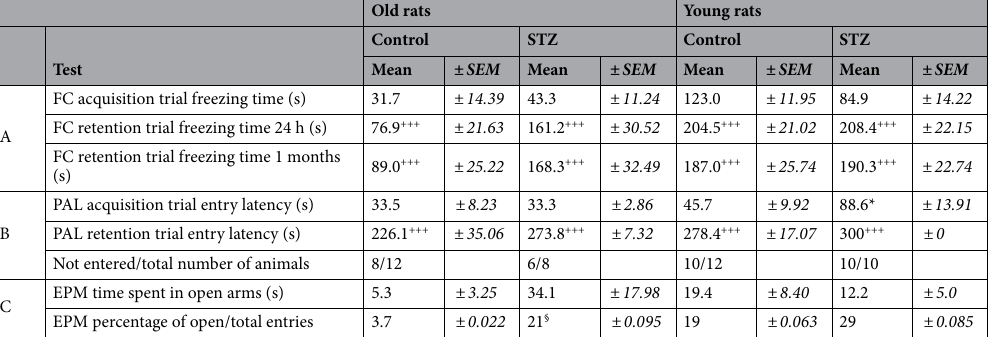
Table 1. Results of icv. STZ-injected (‘STZ’) and vehicle-treated (‘control’) rats in various behavioral assays. (A) Learning performance in the Fear conditioning paradigm. ‘Old rats’ column: + + + : p < 0.001 significant difference vs acquisition trial (post-hoc Duncan-test following repeated measures ANOVA with significant ‘trial’ effect (F(2, 40) = 18.36, p = 0.000). ‘Young rats’ column: +++: p < 0.001 significant difference vs acquisition trial (post-hoc Duncan-test following repeated measures ANOVA with significant ‘trial’ effect (F(2, 44) = 43.54, p = 0.000). Group size of old STZ-treated rats: n = 11 at retention trial 24 h and n = 10 at 1 month. (B) Passive Avoidance Learning. ‘Old rats’ column: +++: p < 0.001 significant difference vs acquisition trial (post-hoc Duncan-test following repeated measures ANOVA with significant ‘trial’ effect (F(1, 18) = 89.44, p = 0.000). ‘Young rats’ column: *: p < 0.05 significant difference vs control: unpaired t-test, t(20) = −2.56, effect size: 1.15; + + + : p < 0.001 significant difference vs. acquisition trial (post-hoc Duncan-test following repeated measures ANOVA with significant ‘treatment’ (F(1, 20) = 5.41, p = 0.030) and ‘trial’ (F(1, 20) = 397.41, p = 0.000) effects. Group size of old STZ-treated rats: n = 8. (C) Elevated plus maze results. ‘Old rats’ column: § p = 0.042 significant difference vs control (Mann–Whitney U-test, U = 29; because of variance inhomogeneity non- parametric test was used), effect size: 0.91. Group size of old STZ-treated rats: n = 10. Group size of young STZ-treated rats: n =